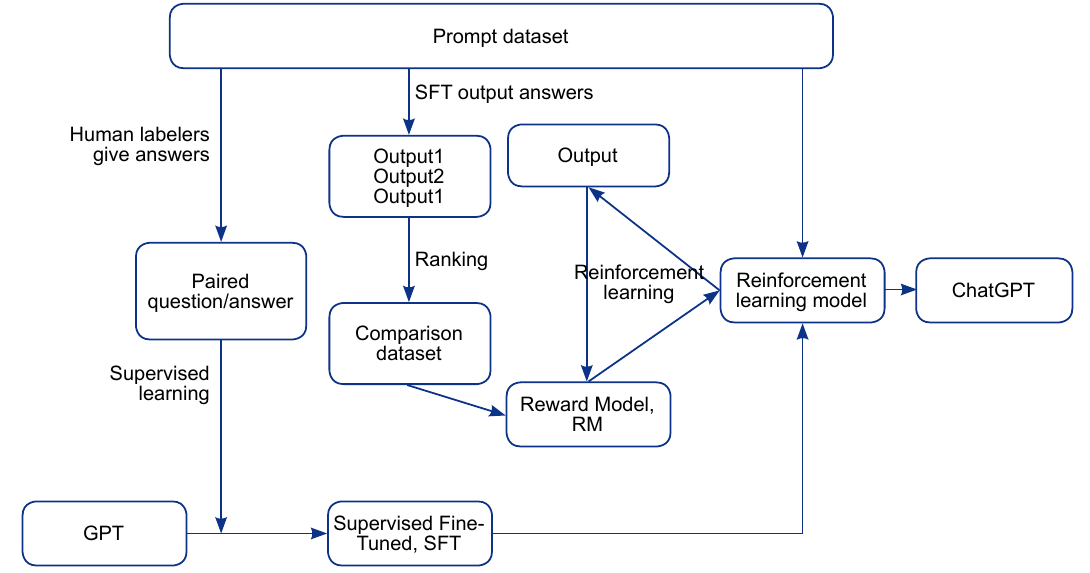
Figure 1 The training process from GPT to